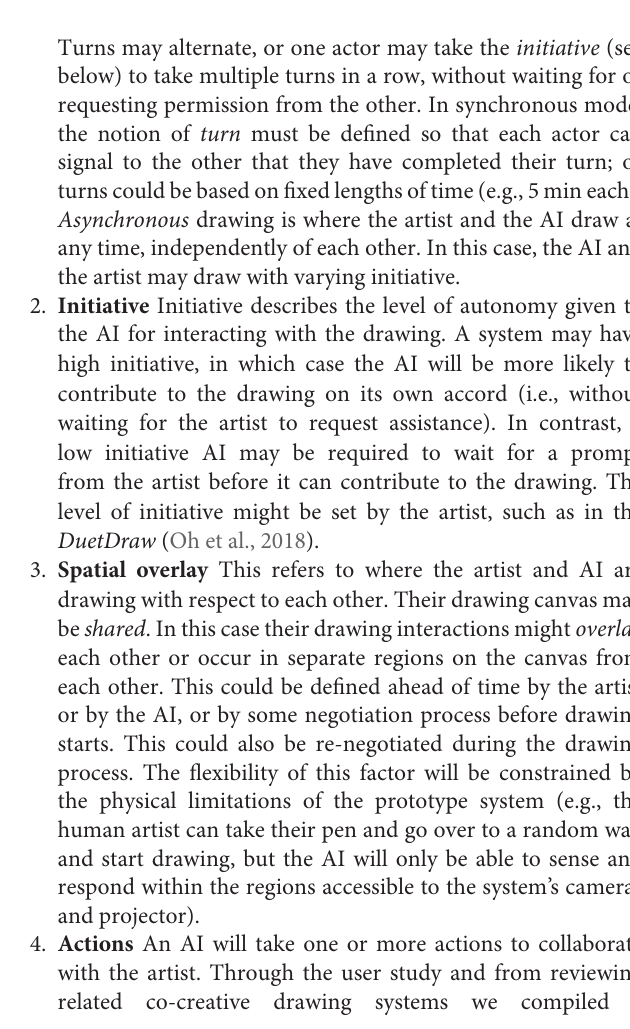
FIGURE 8 | (Left) Design of prototype research system with Raspberry PI cameras (1a–c) , depth camera (2) , and WACOM Bamboo Slate digital “sketchpad” (3) , each with a dedicated Raspberry PI communicating via ROS (http://ros.org). (Right) Schematic for prototype research system.